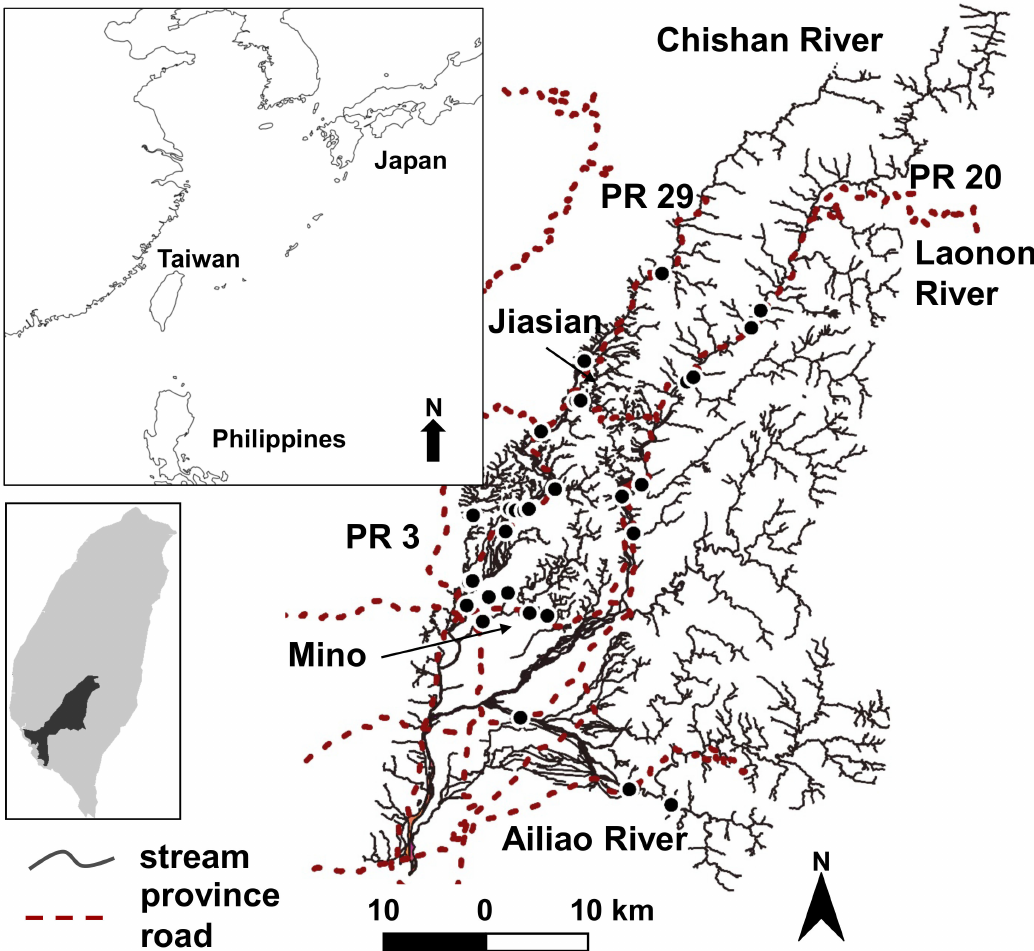
Figure 1. Locations of sampling sites in the Kaoping Creek catchment, Taiwan. PR is the abbrevi- ation for province road; for example, PR 3 is province road 3. Mino and Jiasian are townships in the